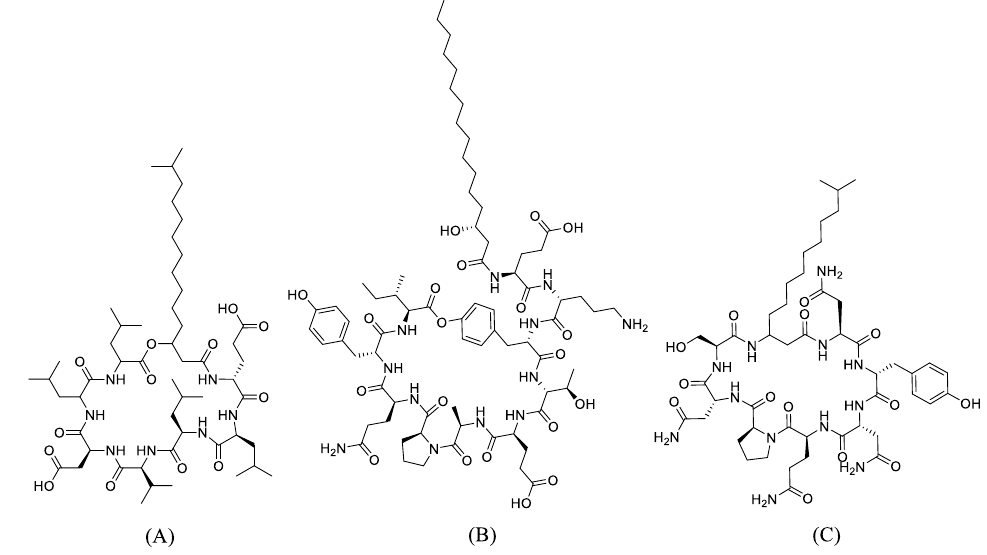
Figure 1. The 2D structures of the ligands: ( A ) Surfactin, ( B ) Fengycin, and ( C ) Iturin A. The results of the molecular docking analysis indicated that each ligand, particularly fengycin and surfactin, had a strong interaction with the receptor (Table 3). The binding free energy of the ligands to the PBP1 receptor varied between − 103.21 and − 124.42 kcal/mol. Iturin A had the lowest value ( − 124.42 kcal/mol), followed by surfactin ( − 118.37), then fengycin ( − 103.21 kcal/mol), in comparison to ceftriaxone ( − 117.49 kcal/mol), cefixime ( − 105.15 kcal/mol), and doxycycline ( − 104.23 kcal/mol). While the binding free energy of the ligands to the PBP2 receptor varied between − 103.74 and 137.87 kcal/mol. Iturin A pro- duced a value of − 127.67 kcal/mol, followed by fengycin ( − 114.55 kcal/mol) and surfactin ( − 103.74), compared with ceftriaxone ( − 137.87 kcal/mol), cefixime ( − 113.39 kcal/mol), and doxycycline ( − 113.13